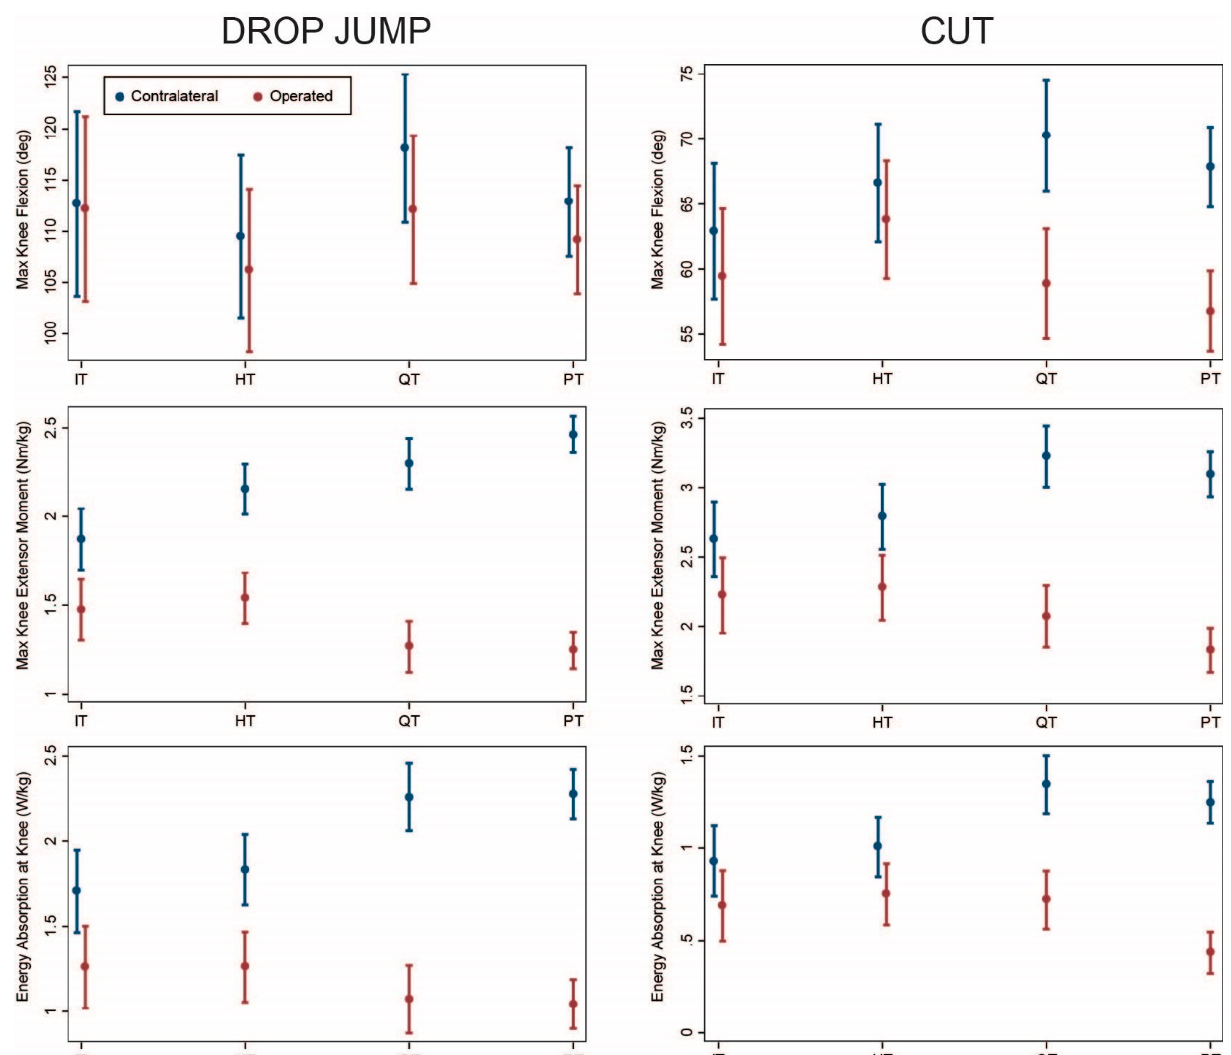
Figure 2. Comparison of operated (red) and contralateral (blue) limbs by graft type (model predicted mean and 95% confidence interval) for patients with isolated ACLR (no concomitant meniscus procedures). IT: iliotibial band; HT: hamstring tendon; QT: quadriceps tendon; PT: patellar tendon.